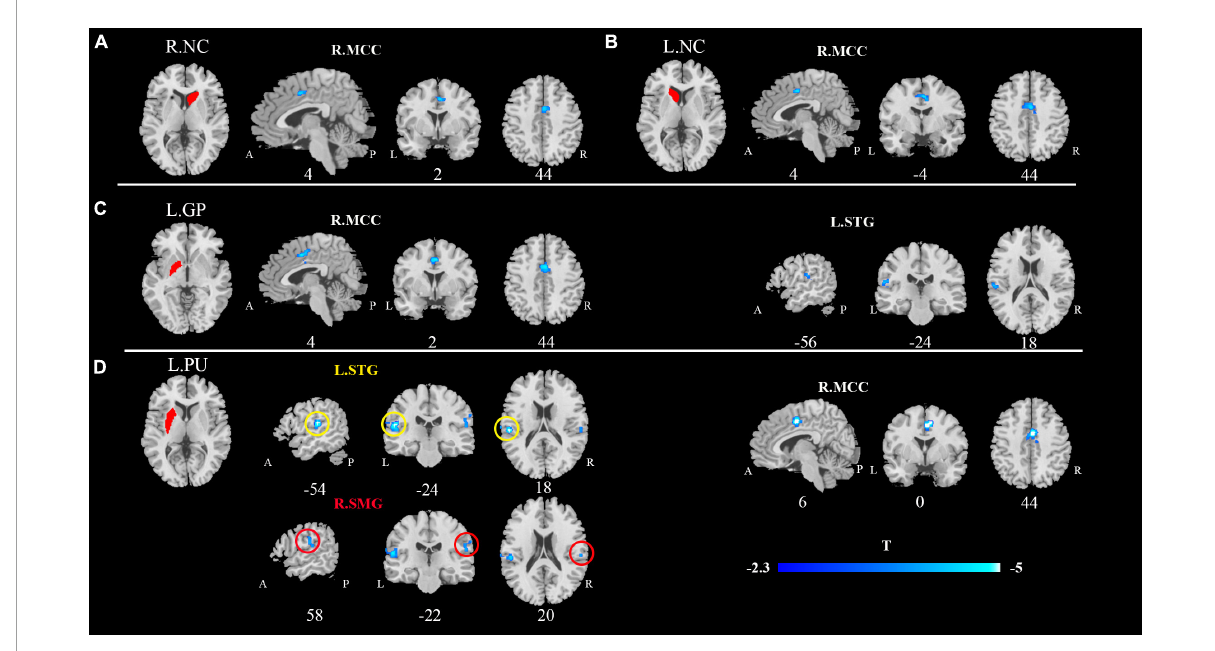
FIGURE1 Decreased functional connectivity of CP/CPPS in contrast to healthy controls between the seed regions. (A) R.NC; (B) L.NC; (C) L.GP; (D) L.PU and affected brain regions. All images were shown with an FDR correction of P < 0.05. R, right; L, left; NC, Caudate nucleus; PU, putamen; GP, Globus